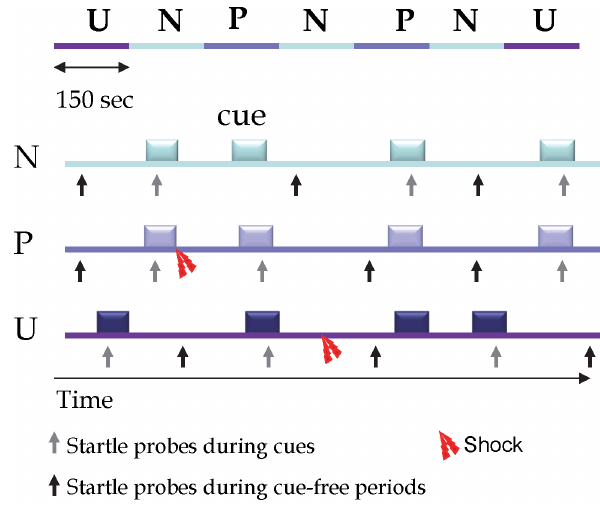
Figure 1. Schematic representation of sequences of stimulus presentation during each condition in one block of the NPU- threat test. The upper part of the figure represents a complete block, including two P (predictable), two U (unpredictable) and three N (no shock) conditions (order UNPNPNU as shown or PNUNUNP). The lower part shows each condition, including cues (8-s duration), startle probes presented during cues (grey arrow pointing up) or during cue-free periods (dark arrow pointing up), and shocks. Adapted from